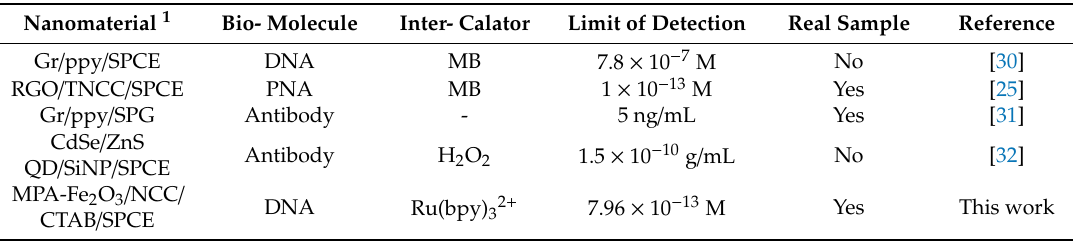
1 Gr / ppy / SPCE (graphene / polypyrrole / screen printed carbon electrode); RGO / TNCC / SPCE (reduced graphene oxide / TEMPO-nanocellulose / screen printed carbon electrode); SPG (screen printed gold); CdSe / ZnS QD / SiNP / SPCE (cadmium selenide / zinc sulfide quantum dots / silica